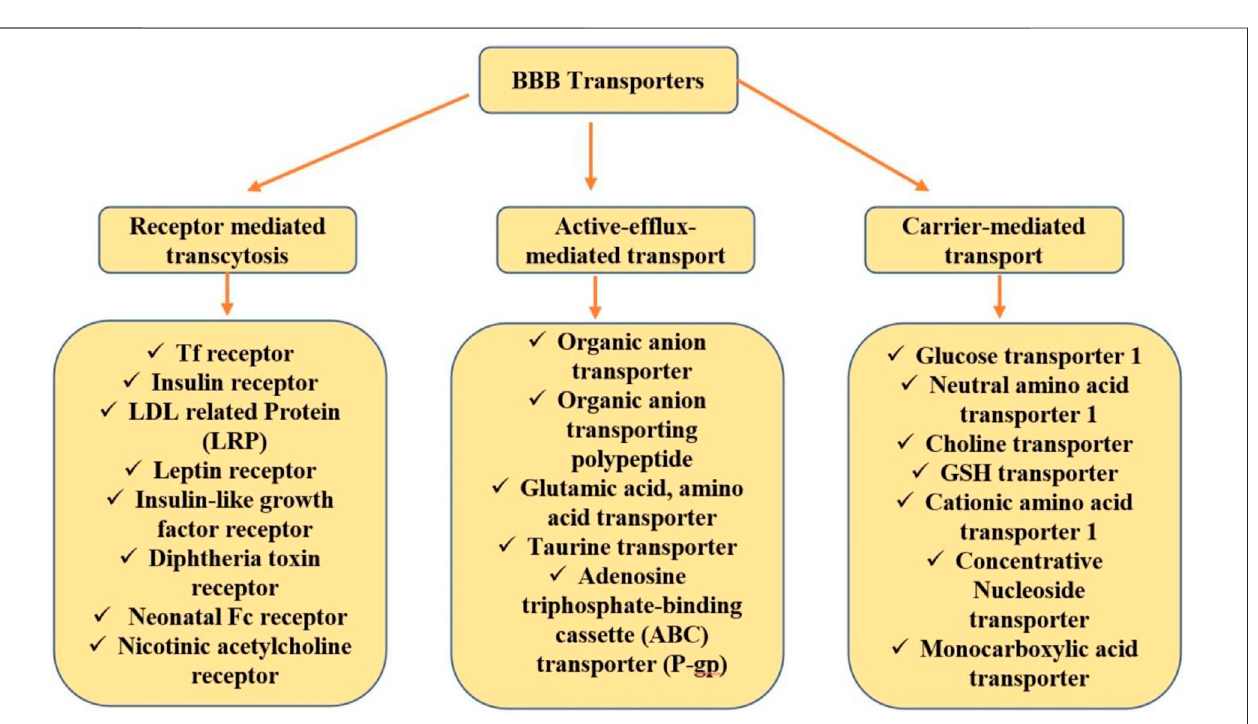
FIGURE 1 | BBB transporters. BBB, blood – brain